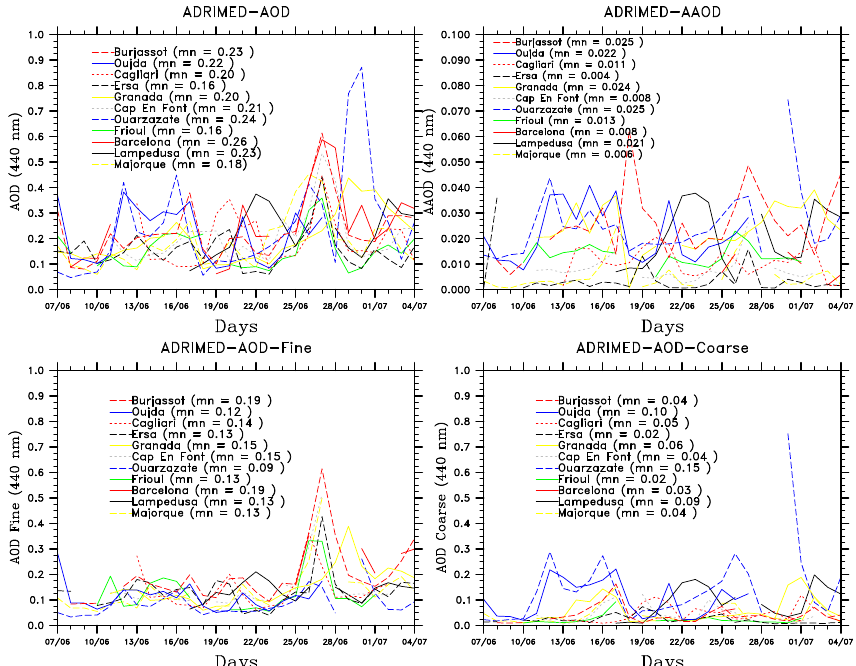
Figure 19. AERONET/PHOTONS observations of the total extinction AOD, AOD Fine (AODf), AOD Coarse (AODc) and Absorbing AOD (AAOD), at 440nm obtained for the whole SOP-1a